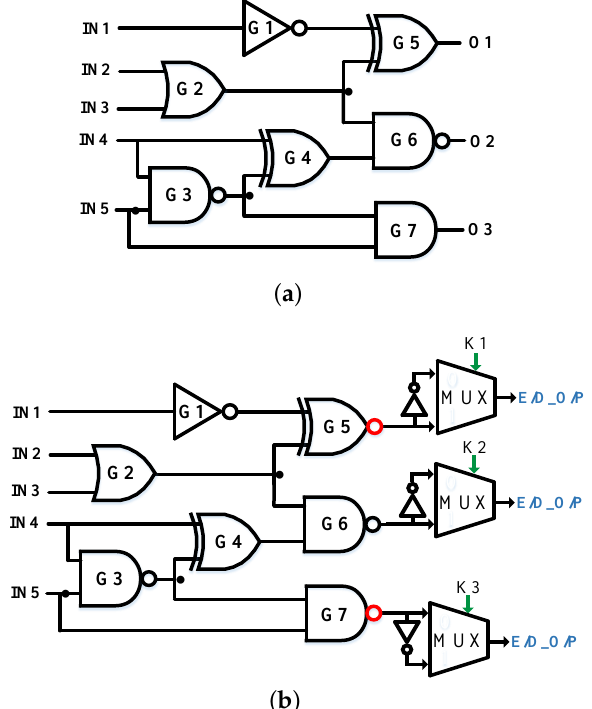
Figure 13. ( a ) Example for an original circuit; ( b ) the encrypted circuit using the MUX key-gate insertion